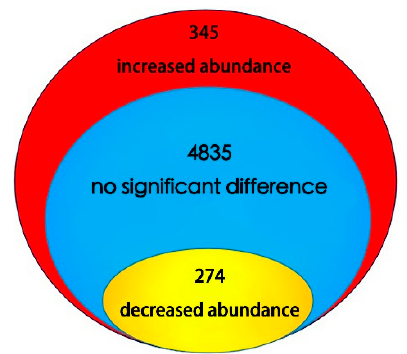
Figure 4. The distribution of proteins with differential abundance.